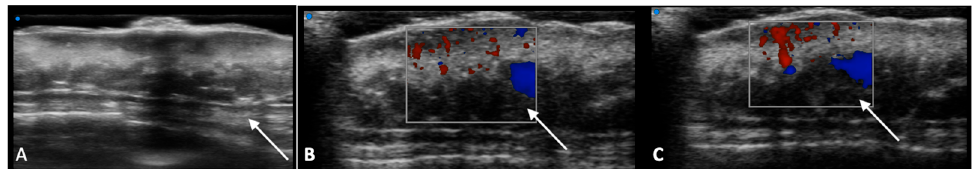
Figure 2. US examination performed with a very high frequency probe (48 Mhz) ( A ) Upper frontal skin site with evident post-actinic scar already treated with previous radiotherapy. ( B ) Round hypoechoic area of the hypodermis with non-encapsulated blurred margins ( C ) The lesion shows intralesional micro-vasculature on Color Doppler control.